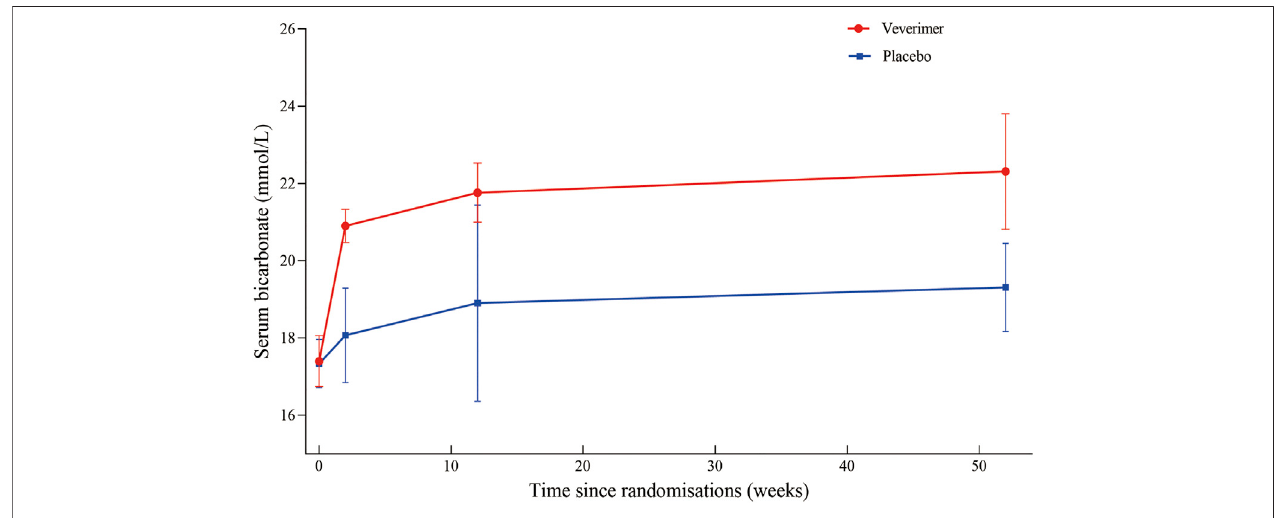
FIGURE 4 | Changes in bicarbonate levels in the two groups during the 52 weeks.